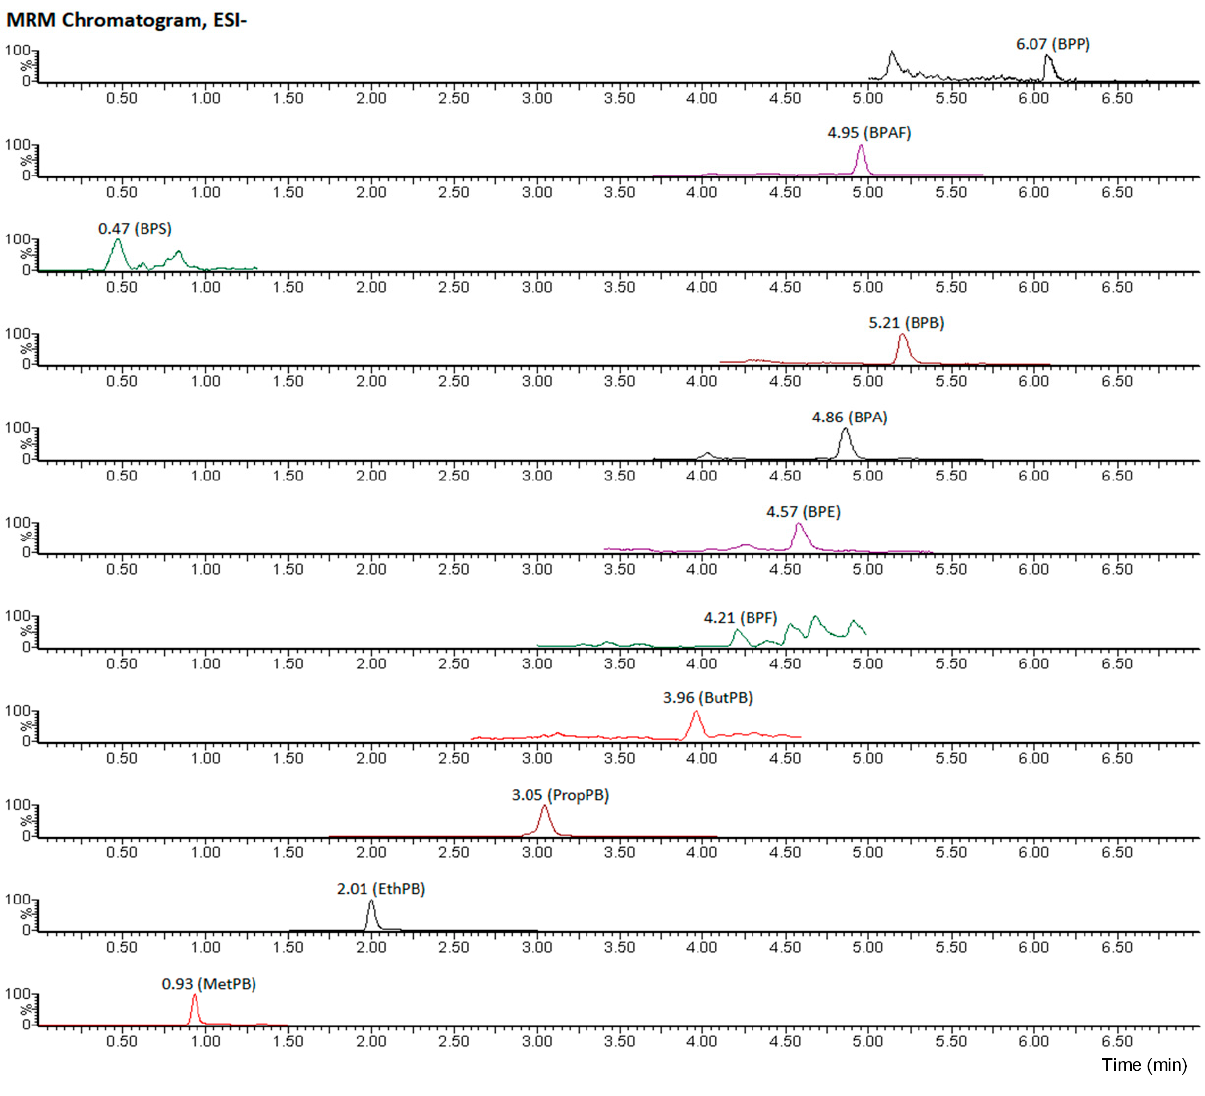
Figure 3. Chromatogram of the lower calibration level. Table 2. Validation and quality parameters of the